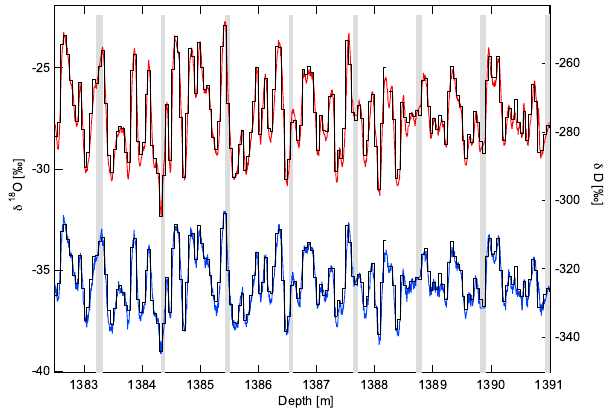
Fig. 6. Comparison CRDS-CFA with 5cm discrete samples for δ D (top) and δ 18 O (bottom). Bars indicate the position and width of sections with missing/removed data.